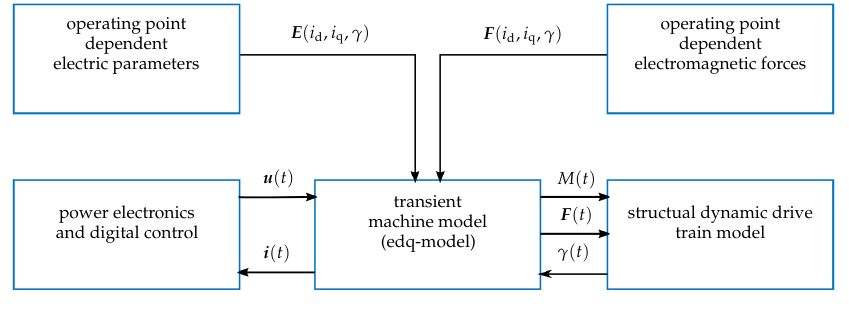
Figure 4. Schematic structure of the extended dq-model (edq-model) according to